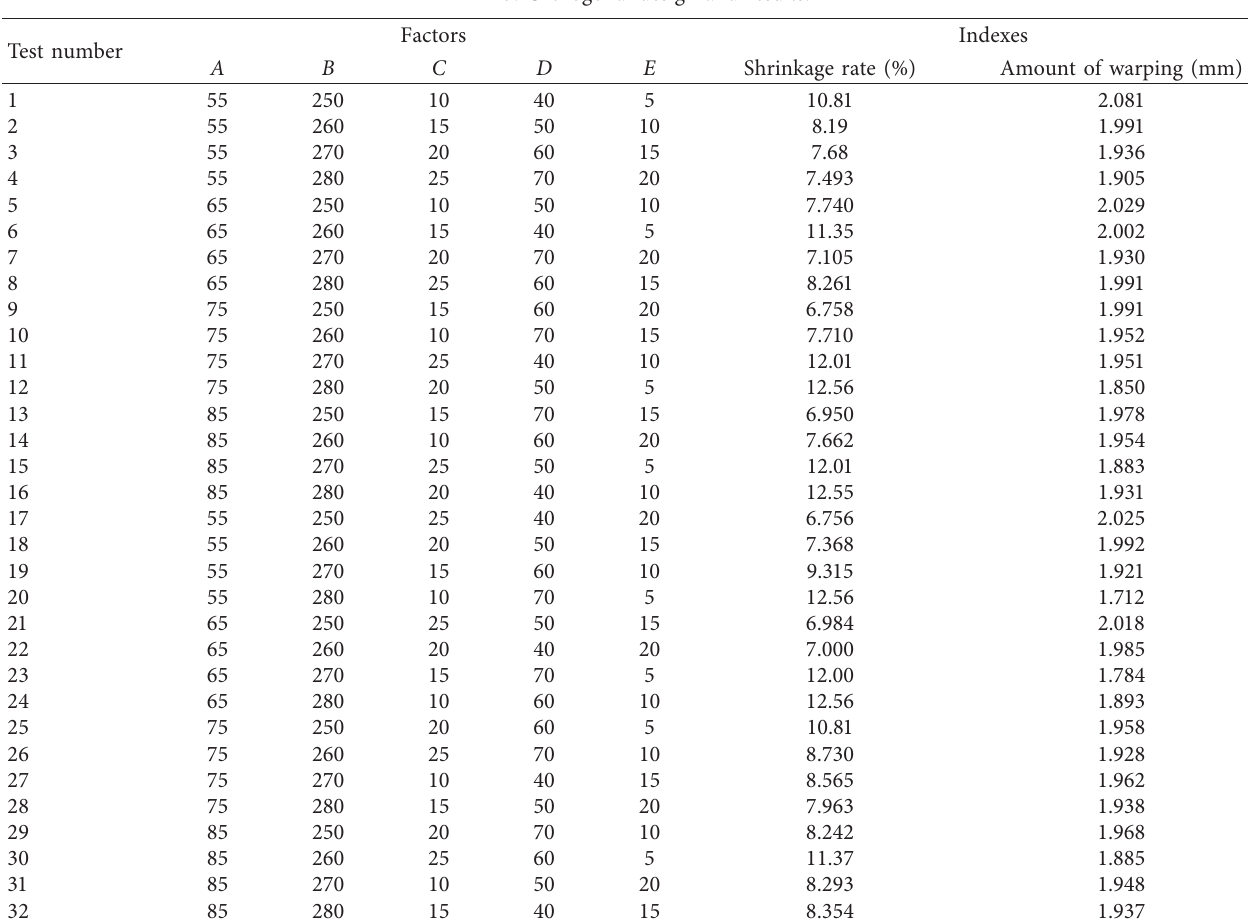
Table 3: Orthogonal design and